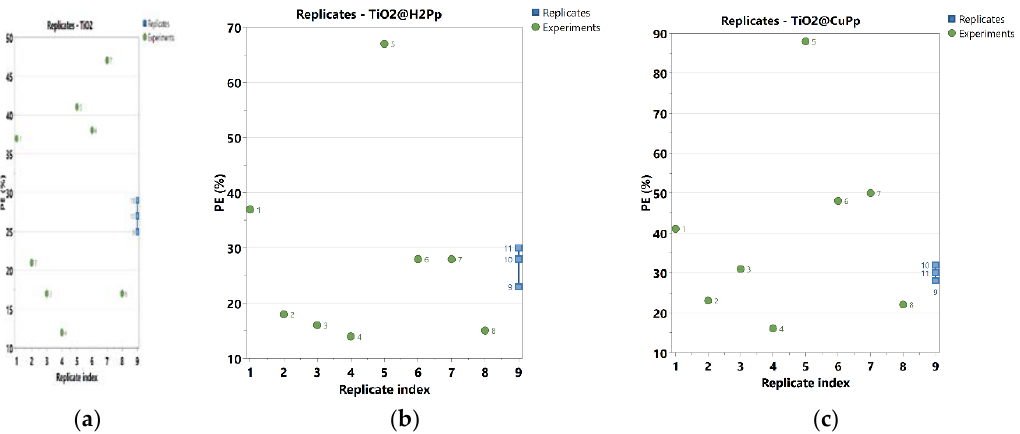
Figure 2. Replicate plots obtained for ( a ) TiO 2 , ( b ) TiO 2 @H 2 Pp, and ( c ) TiO 2 @Cu(II)Pp catalysts.